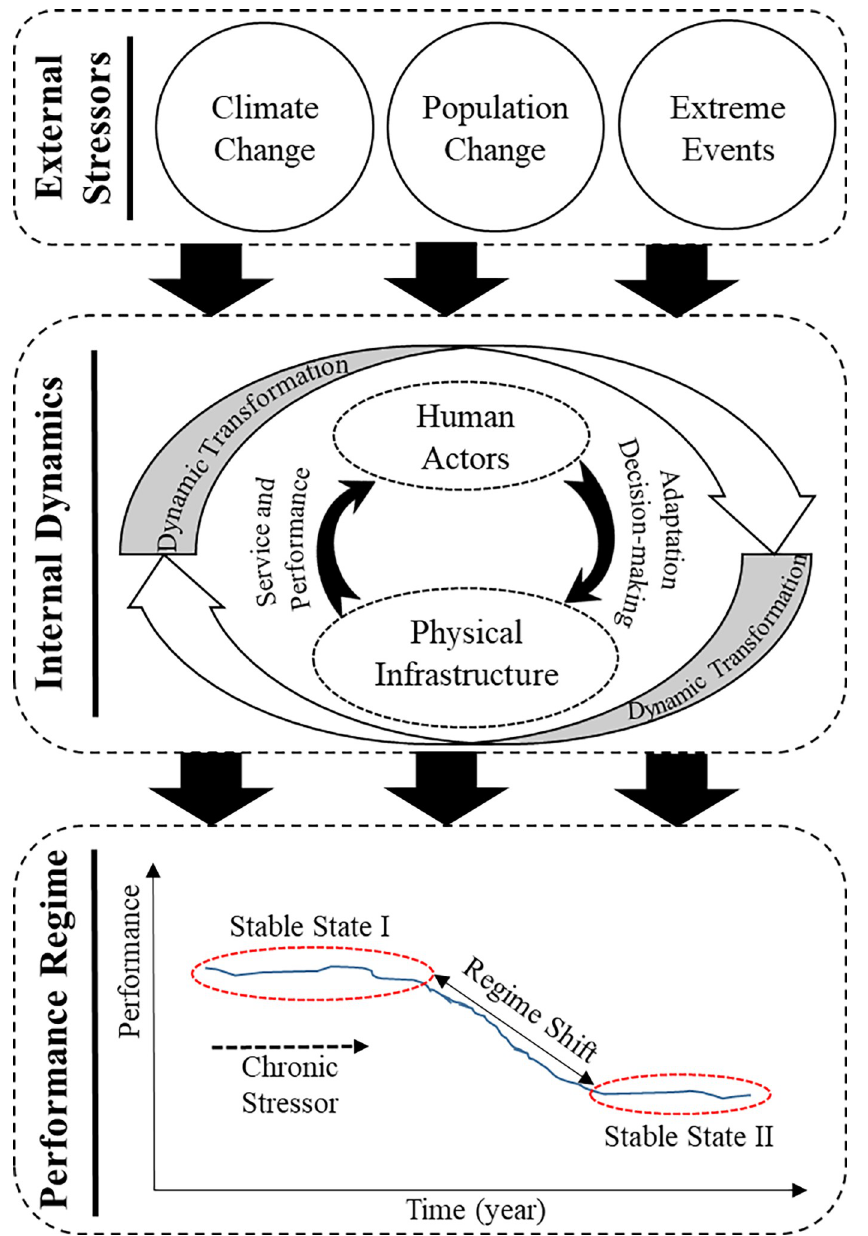
Fig 1. Long-term infrastructure resilience framework using a complex systems